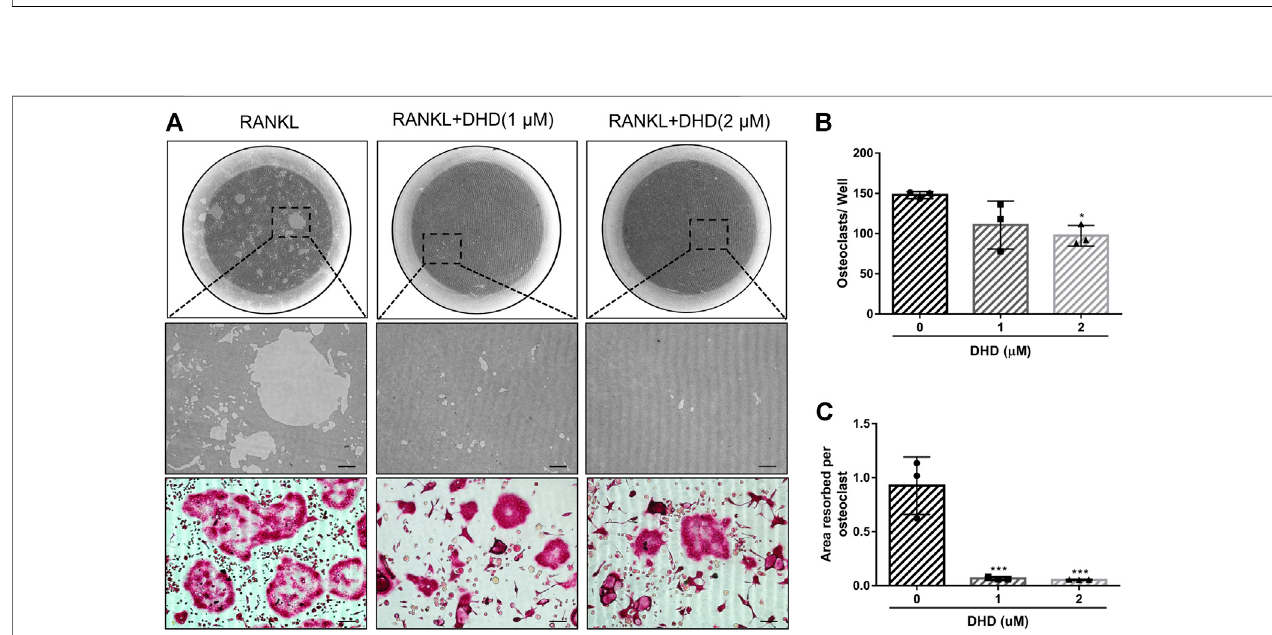
FIGURE 4 | DHD suppresses osteoclastic bone resorption activity. (A) Representative images of eroded regions and TRAcP-stained cells on hydroxyapatite- coated plates in the presence or absence of 1 and 2 μ M DHD (scale bar = 200 μ m). (B) Quantitative analysis of osteoclasts in each well (96-well plate). (C) Quantitative analysis of resorbed proportion per osteoclasts after treatment with the indicated concentrations of DHD (1 and 2 μ M).